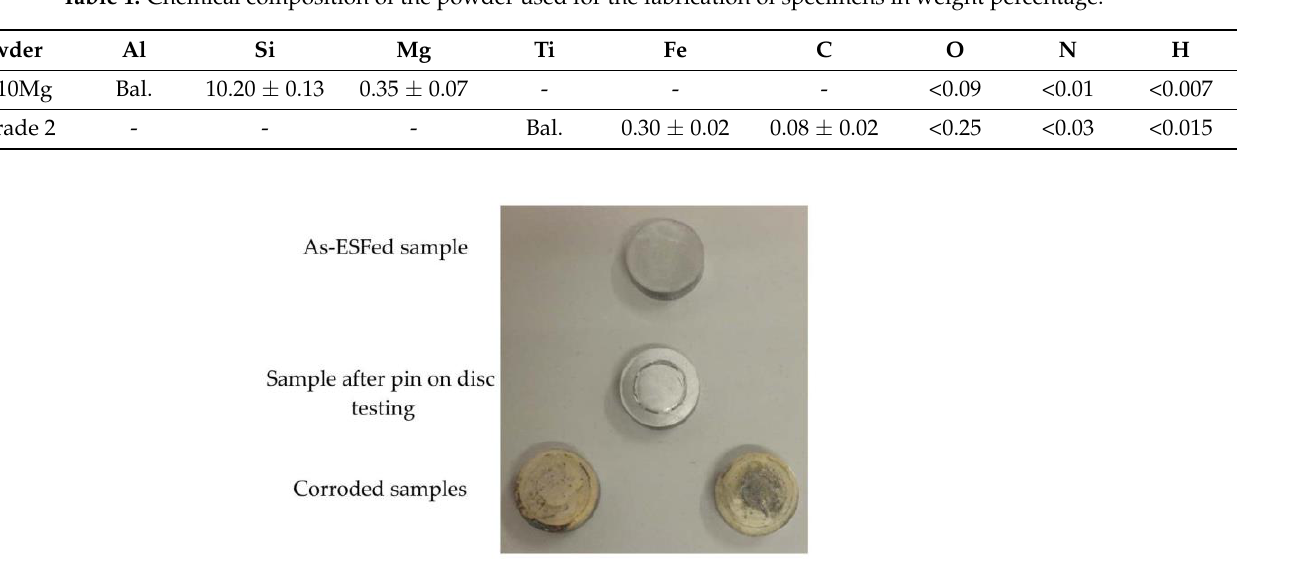
Table 1. Chemical composition of the powder used for the fabrication of specimens in weight percentage. Powder Al